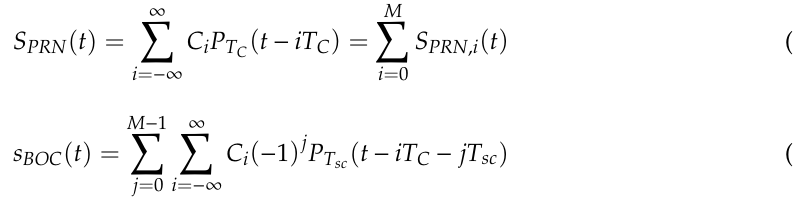
Figure 4. The discrimination curves for the three methods.